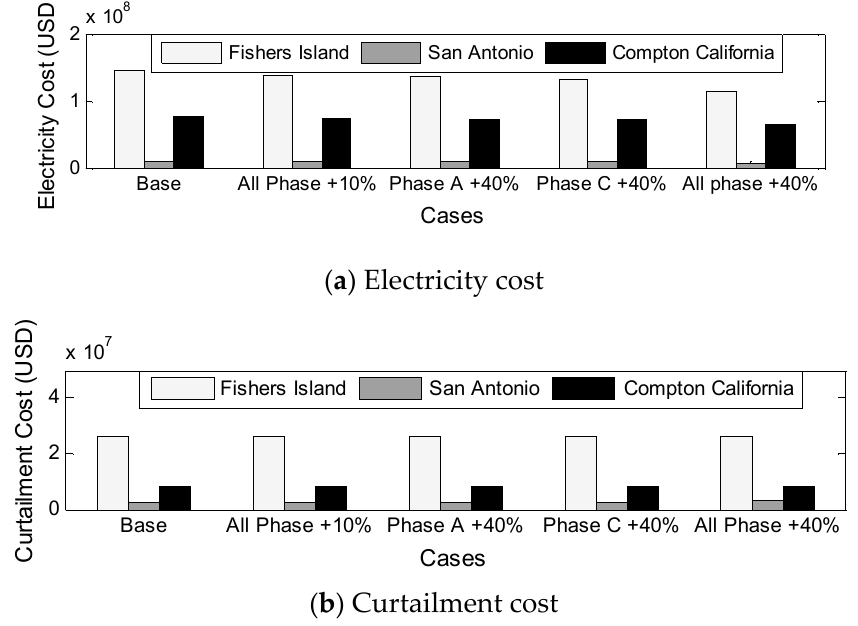
Figure 15. Economics of optimized PV installation.